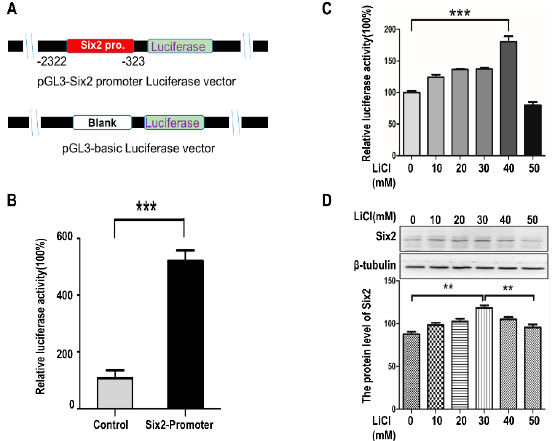
Figure 3. LiCl regulates the expression of Six2 at mRNA and protein level. ( A ) pGL3- Six2 promoter- Luciferase construction was simulate by diagram. The Six2 promoter ranging from − 2322 to − 323 (Six genome sequence) was obtained from NCBI; ( B ) HEK293T cells were co-transfected with pRL-SV40 (renilla control) and pGL3- Six2 promoter-LuC for 36 h. Luciferase activity was normalized to Renilla control. p -values were calculated by Student t -test. Values represents mean values ± SEM of triplicate experiments, *** p < 0.001 relative to control; ( C ) HEK293T cells were co-transfected with pRL-SV40 (renilla control) and pGL3- Six2 -LuC for 36 h then were treated with LiCl of increasing dosages for 12 h. Luciferase activity was measured using dual luciferase reporter assay, normalized to Renilla control. Values were presented as mean ± SEM ( n = 3), *** p < 0.001 relative to control; ( D ) mK3 cells were treated with LiCl of increasing dosages for 12 h. The Six2 expression at protein level was tested by Western-blot. Values were presented as mean ± SEM ( n = 3), ** p < 0.01 relative to control.